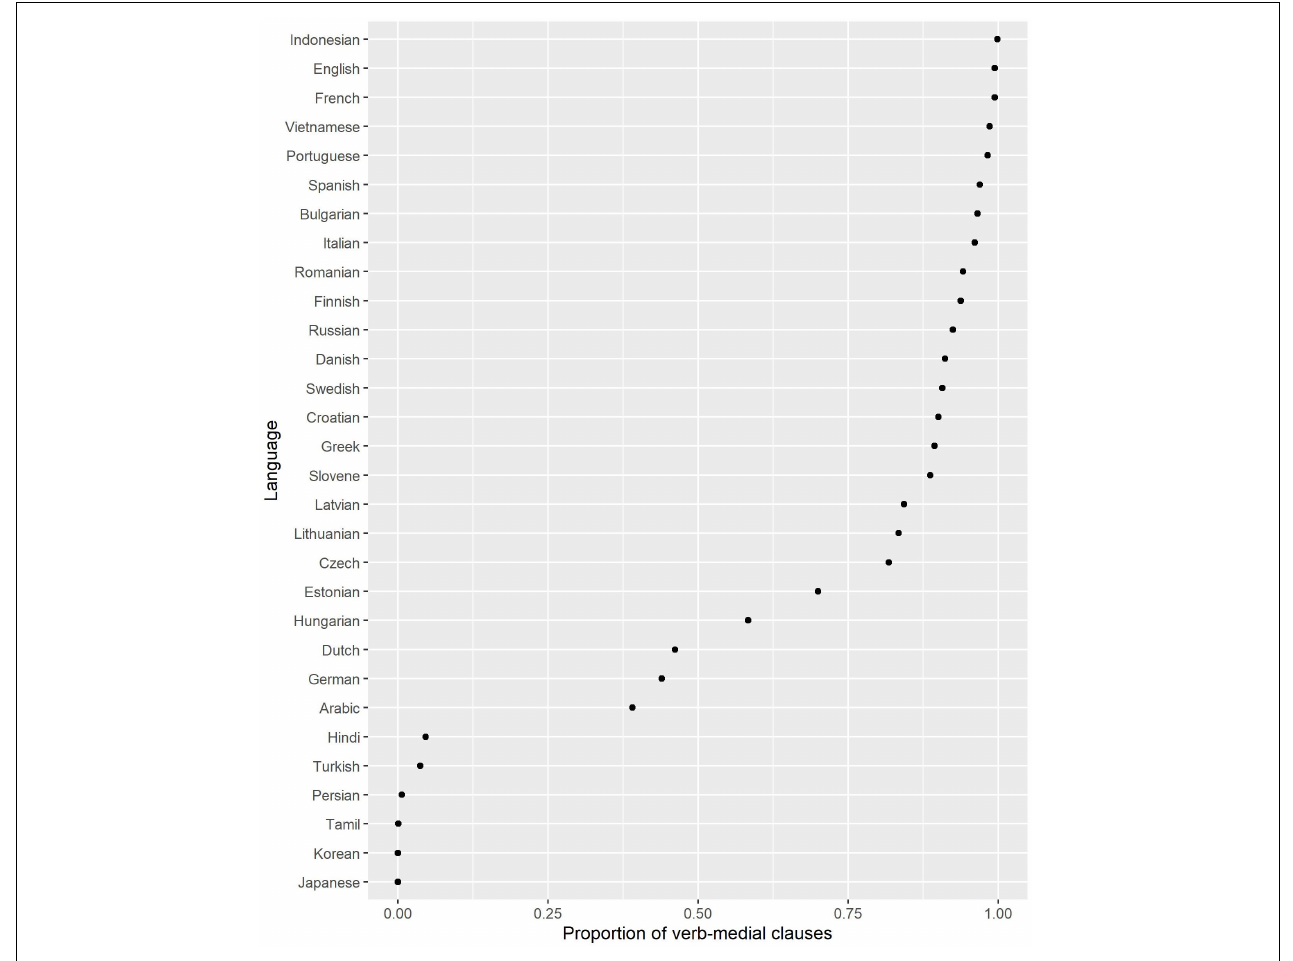
FIGURE 4 | Proportion of verb-medial clauses.